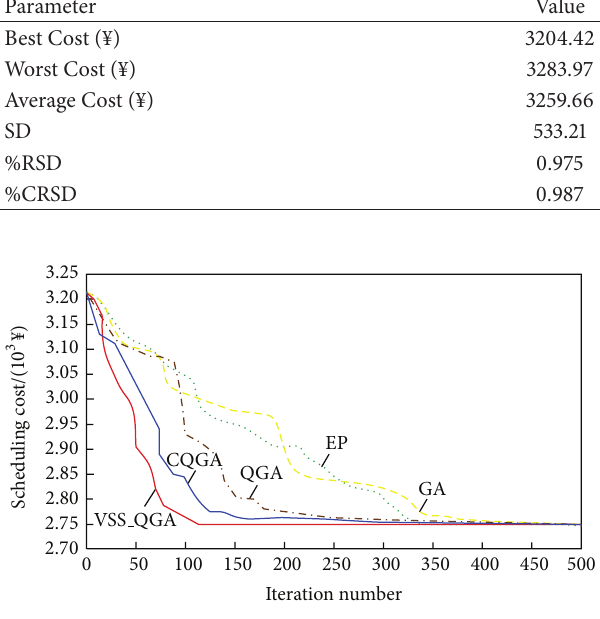
Figure 7: Calculation results of GA, EP, QGA, CQGA, and VSS